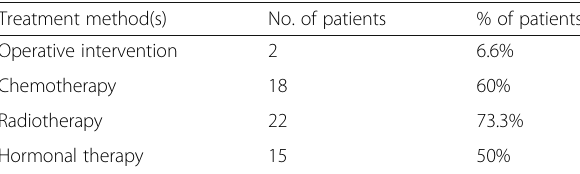
Table 2 Treatment methods for the patients in the study with demonstration of their number (No.) and percent (%)